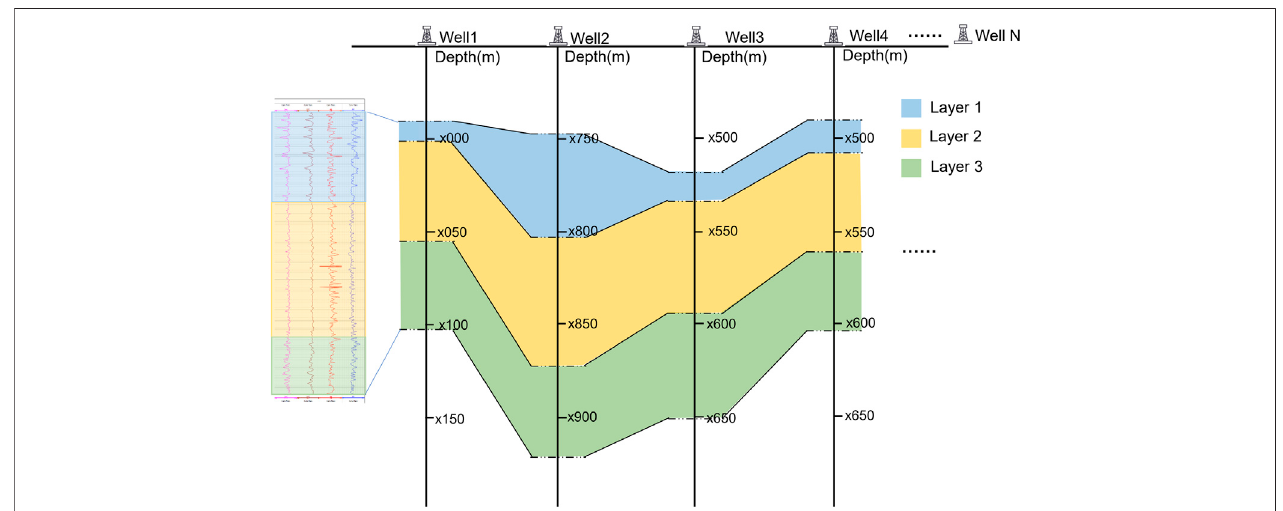
FIGURE 4 | Schematic diagram of target formation depth for different wells, which is the known information in the research fi eld.